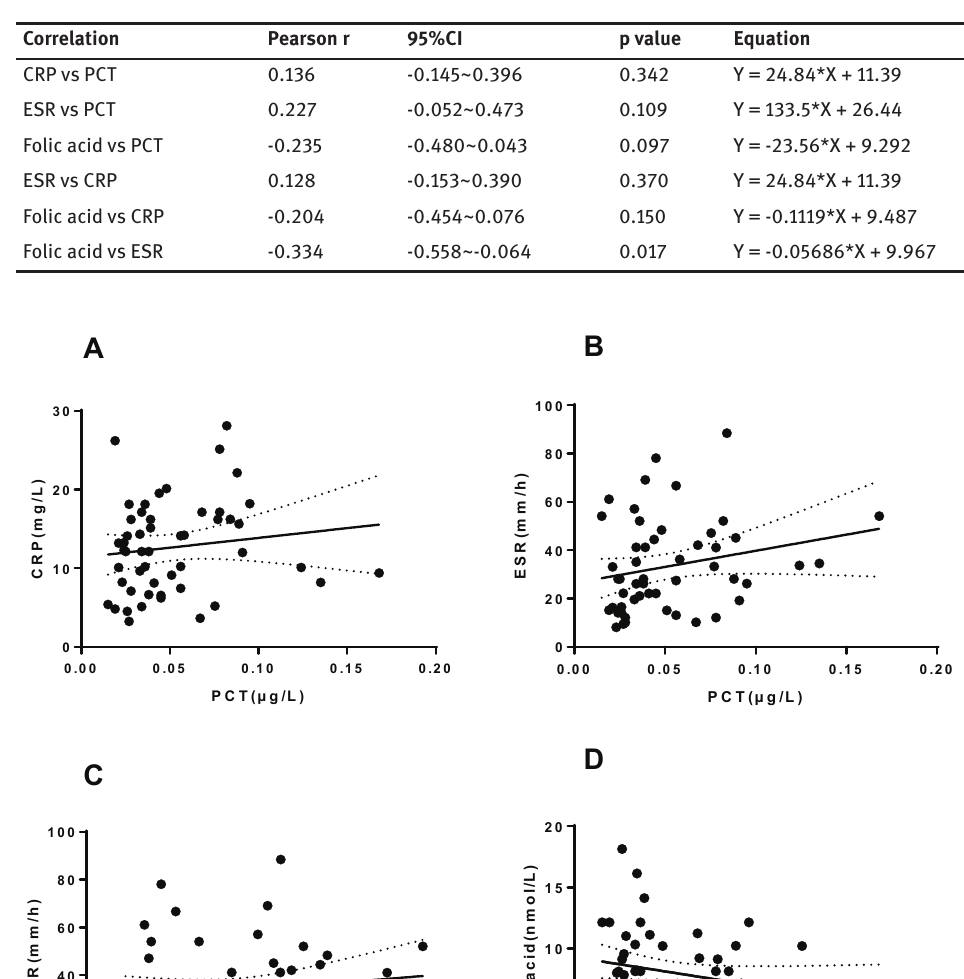
Table 3: Pearson correlation and line regression analysis among serum CRP, ESR and PCT.